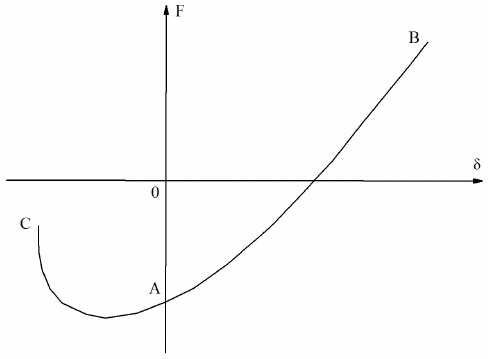
Figure 8. Schematic illustration of the force displacement relationship.